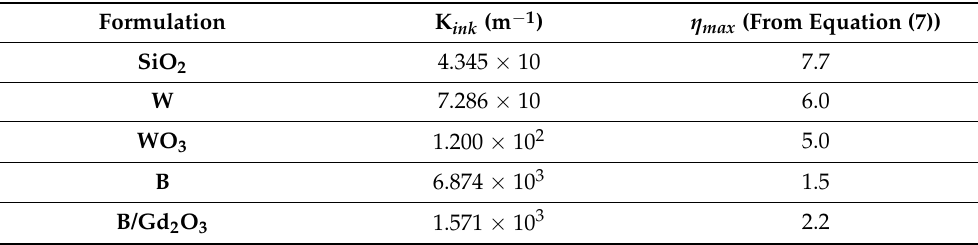
Table 3. Ink parameters for the rheological-tested ink formulations and their maximum spacing ratios according to Equation (7).